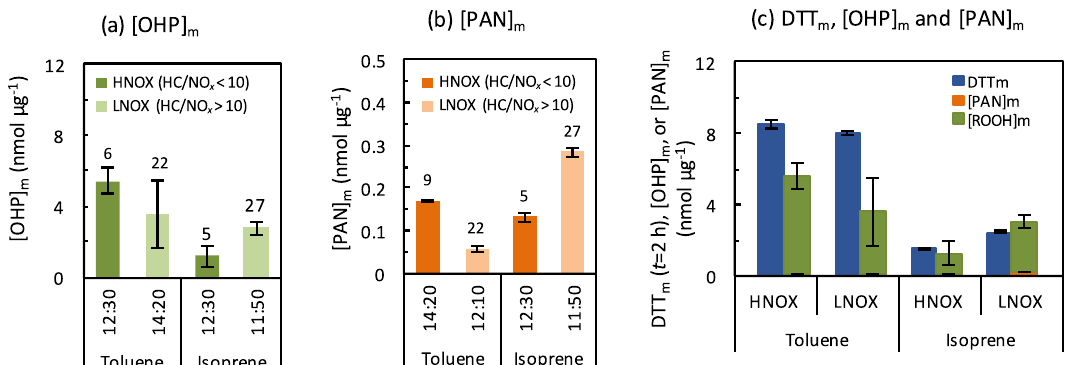
Figure 5. (a) Concentration of organic hydroperoxides in SOA, [OHP] m (nmolµg − 1 ) , measured by NPBA assay. (b) Concentration of PANs in SOA, [PAN] m (nmolµg − 1 ) , measured by Griess assay. The number above each column represents the initial HC / NO x ratio. The x axis represents the mid-collection time (Table 1). (c) Comparison of DTT m ( t = 2h) with the sum of [OHP] m and [PAN] m . The [OHP] m , [PAN] m , and DTT m are expressed as the mean ( ± σ) of three replicates. HNOX represents high-NO x conditions, and LNOX represents low-NO x conditions.